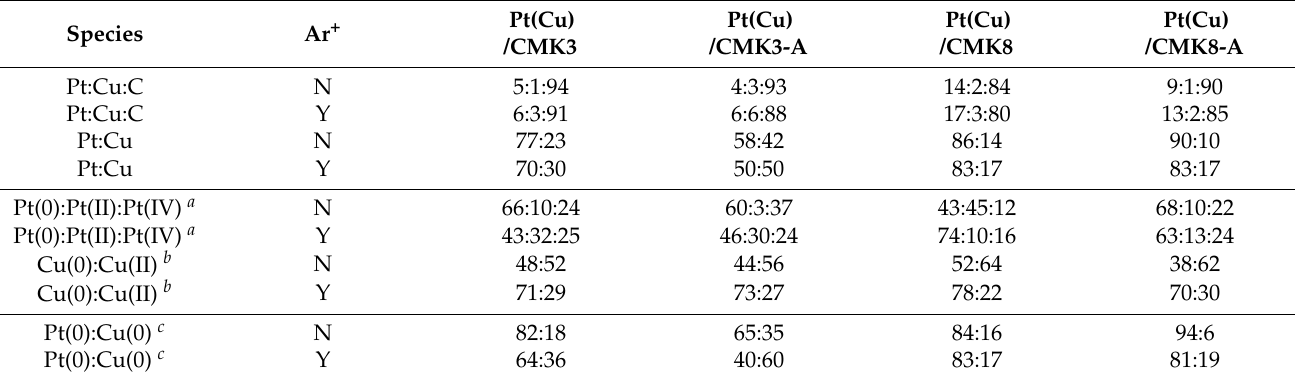
Table 2. Overall Pt:Cu:C and Pt:Cu composition (at.%) for the different catalysts, before (N) and after (Y) Ar + sputtering. Species Ar